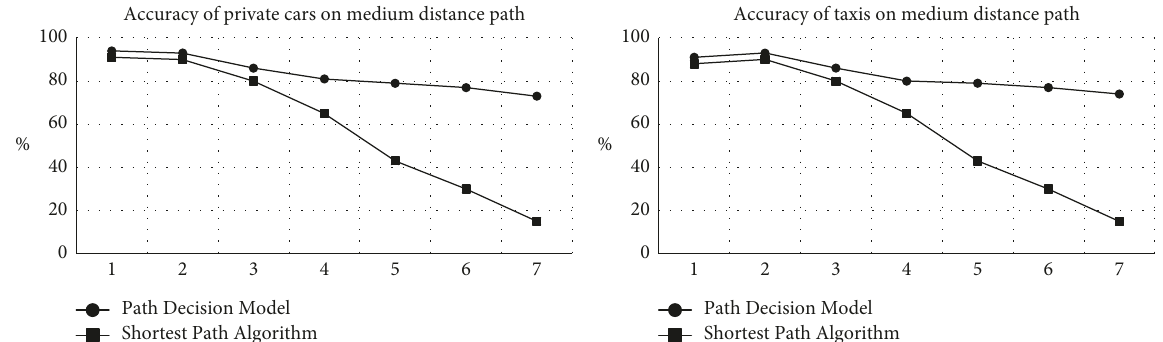
Figure 10: Accuracy of taxis and private cars on medium distance